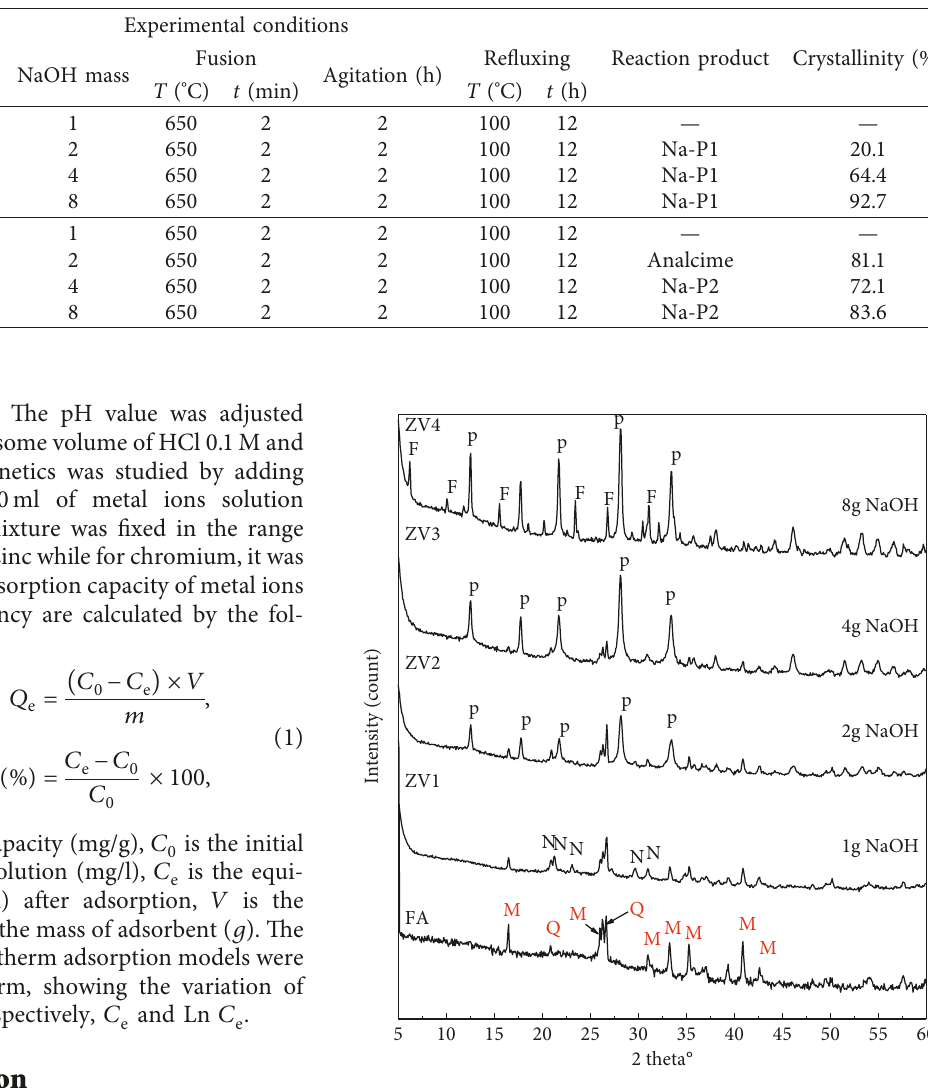
Figure 1: Patterns of FA and synthesis products. M: mullite, Q: quartz, N: sodium aluminosilicate, P: zeolite Na-P1, and F: zeolite